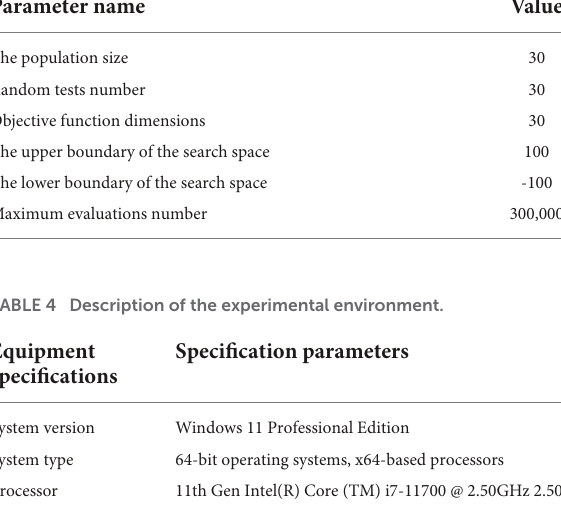
TABLE 3 Parameter setting of the experiment.